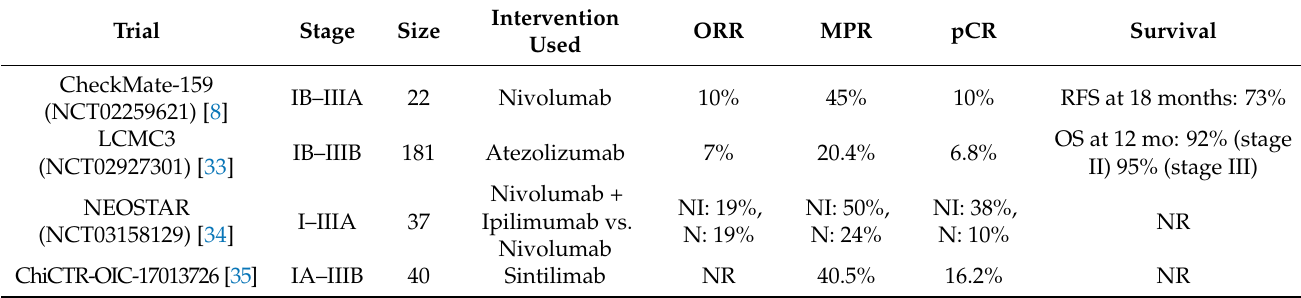
Table 3. Phase II clinical trials of neoadjuvant